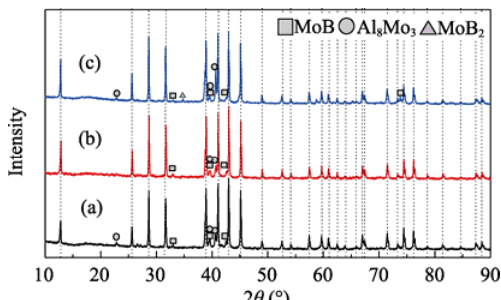
Fig. 4 XRD patterns of the samples synthesized from Mo/1.3Al/ n B by SHS for (a) n = 0.95, (b) n = 1, and (c) n = 1.05, where the dotted lines represent MoAlB.